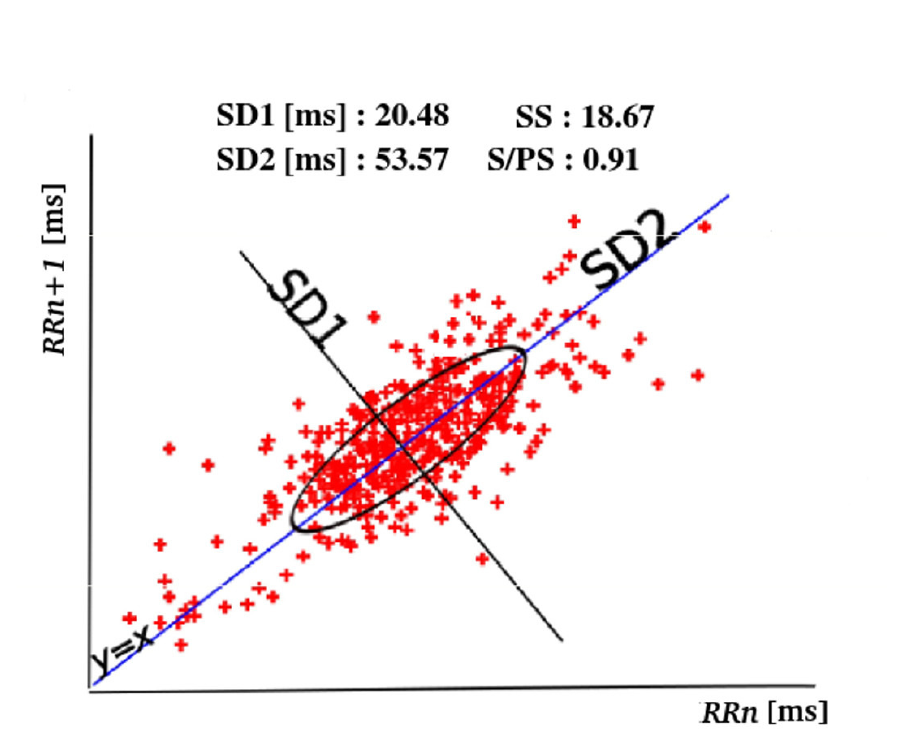
Figure 5: Poincaré graph. The abscissa represents the time interval RRn , the ordinate the next interval RR n + 1 , respectively. The fit to an ellipse, line y = x , SD 1 parasympathetic activity and SD 2 sympathetic activity